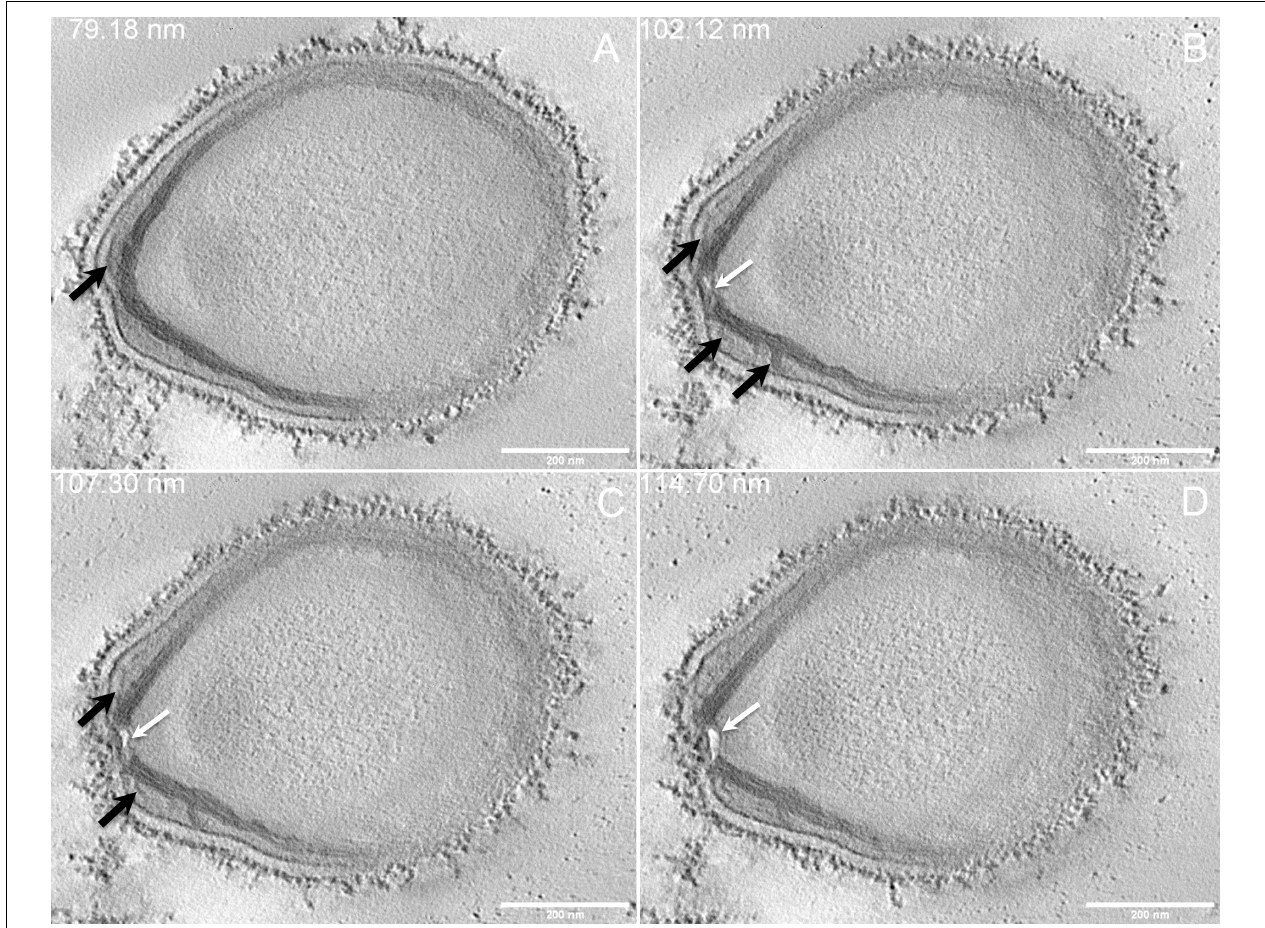
FIGURE 2 | Electron tomography of P. massiliensis particle from Movie 3 . (A–D) Single planes in the tomogram from Movie 3 showing thick tubules protruding toward the periphery and the outer electron-dense membrane (black arrows); a thin tubule/membrane (white arrow) connects the thick tubules layers located on each side of the ostiole.